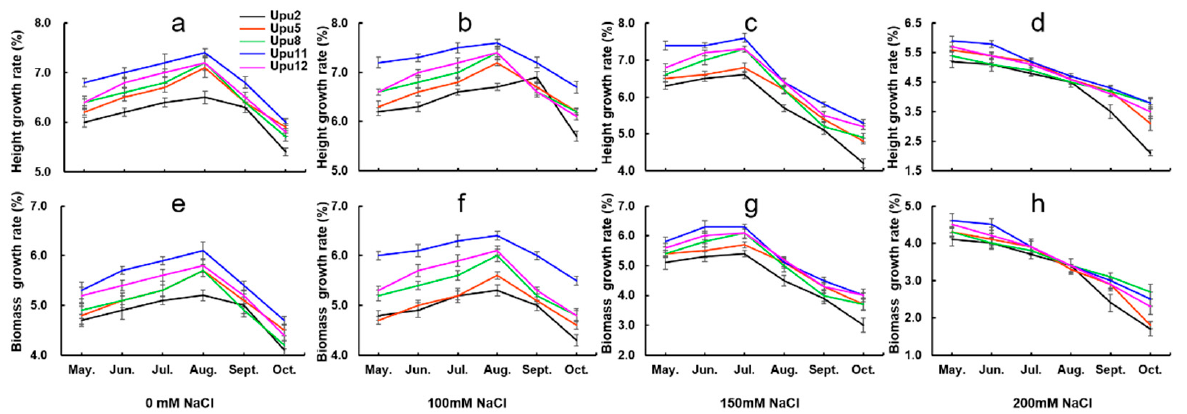
Figure 2. Changes in rates of growth and biomass accumulation. ( a – d ) Changes in growth rates from May to October under control and NaCl treatments; ( e – h ) changes in biomass accumulation rates from May to October under control and NaCl treatments. Values represent means ± SD (n = 3).